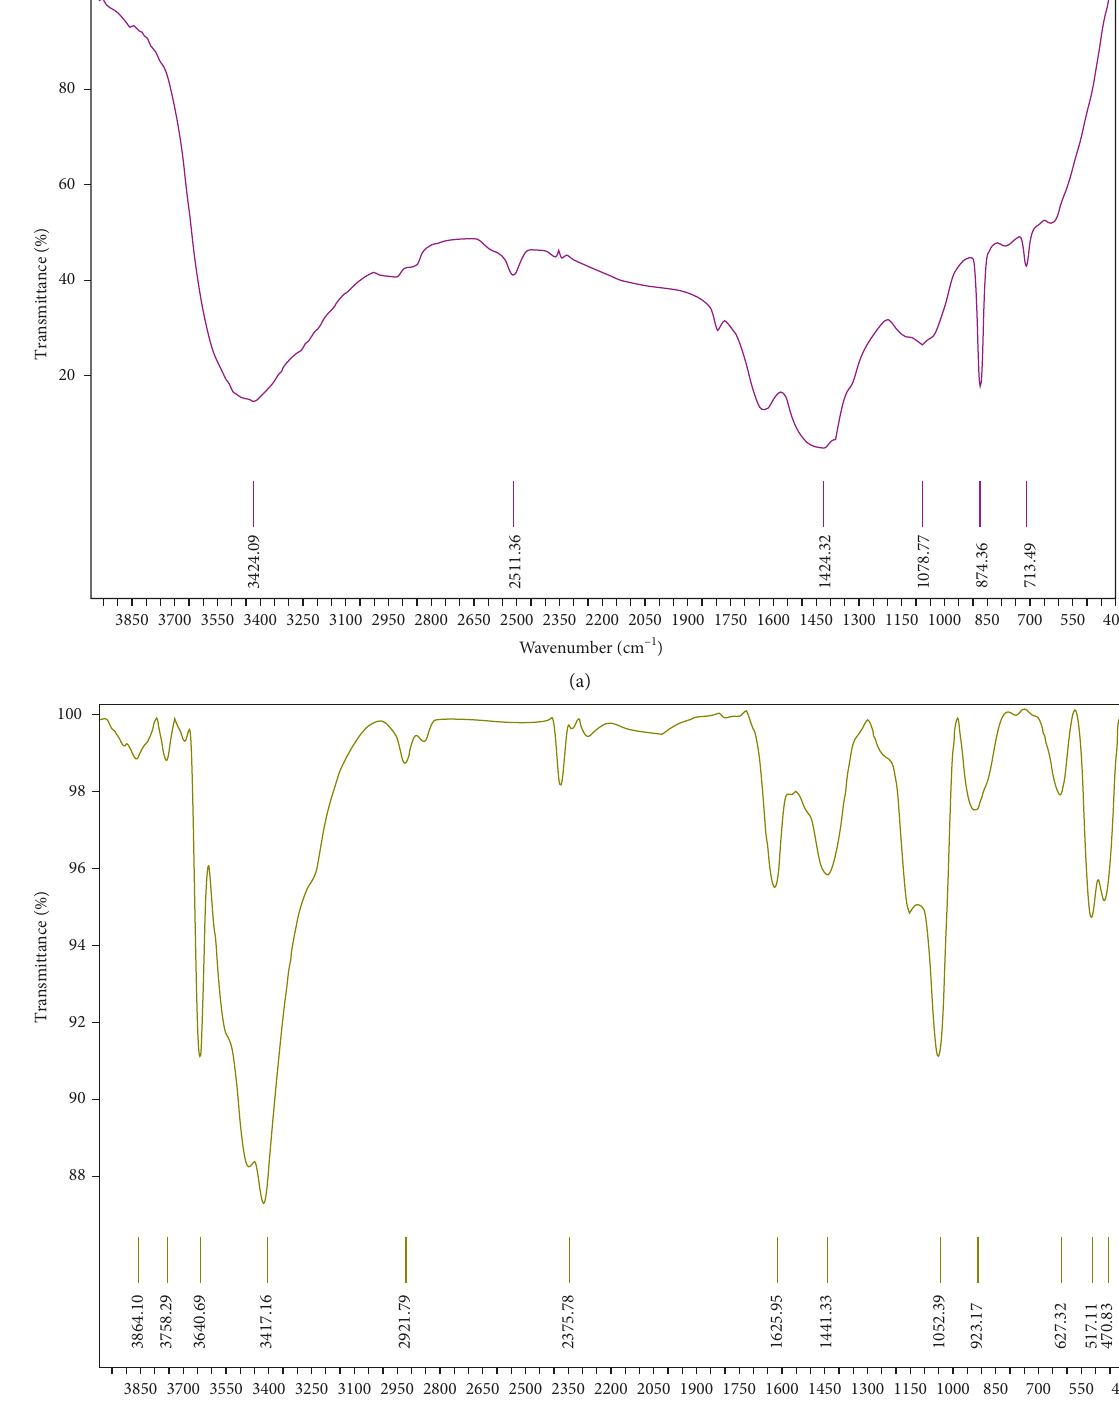
Figure 10: FTIR spectra of (a) sugar scum powder and (b) optimal